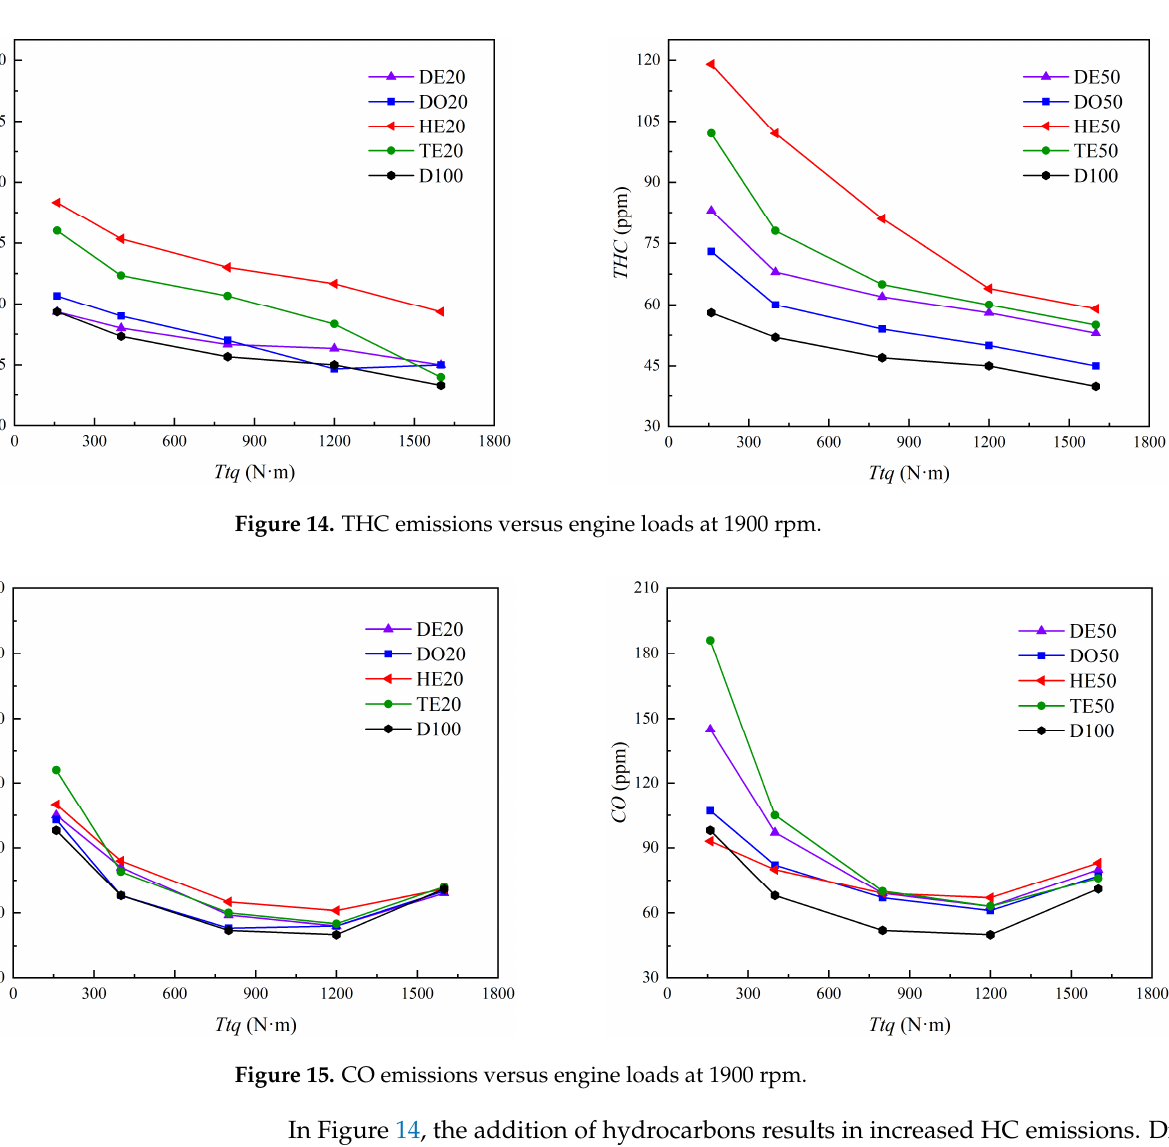
Figure 13. NOx emissions versus engine loads at 1900 rpm.